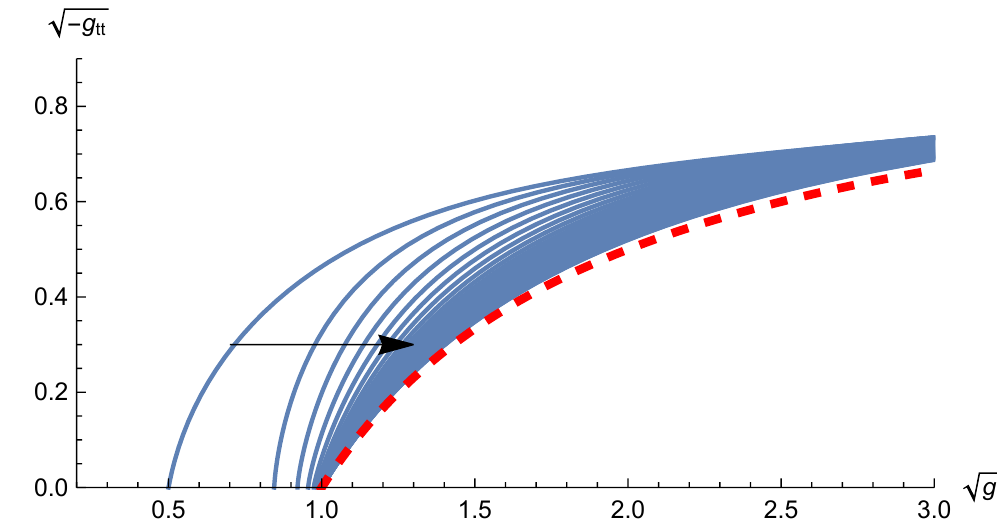
√ √ Figure 10 . Figure showing curves of − g tt plotted against g θθ at constant intervals ( ∆ λ = 0 . 25 ) of flow time, for a non-linear initial deformation of the extremal magnetic RN solution. The RN fixed point is shown in dashed red, and we see the initally deformed geometry asymptotes back towards extremal RN as the flow proceeds.